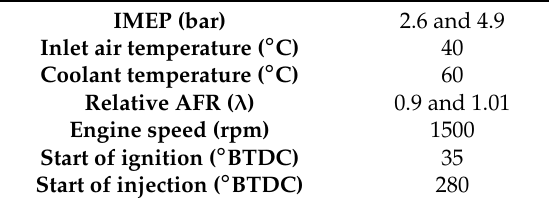
Table 9. Engine operating conditions for GEM fuels and gasoline. BTDC = before top dead